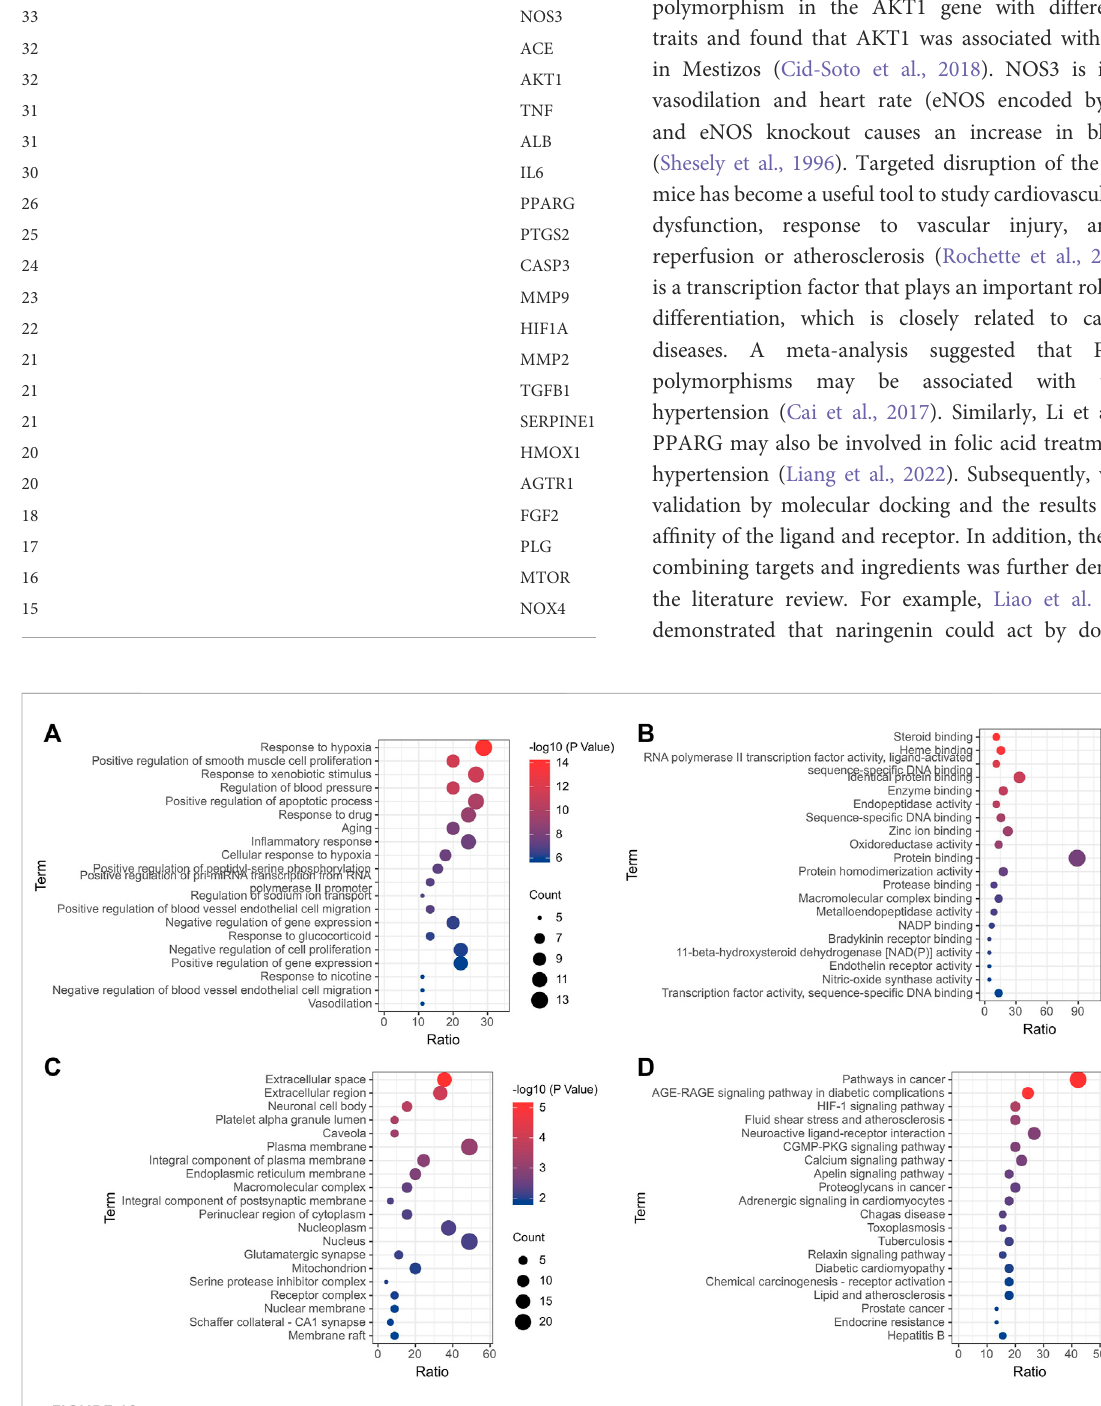
FIGURE 12 Enrichment analysis of gene. (A) Biological process; (B) Molecular function; (C) Cellular components; (D)